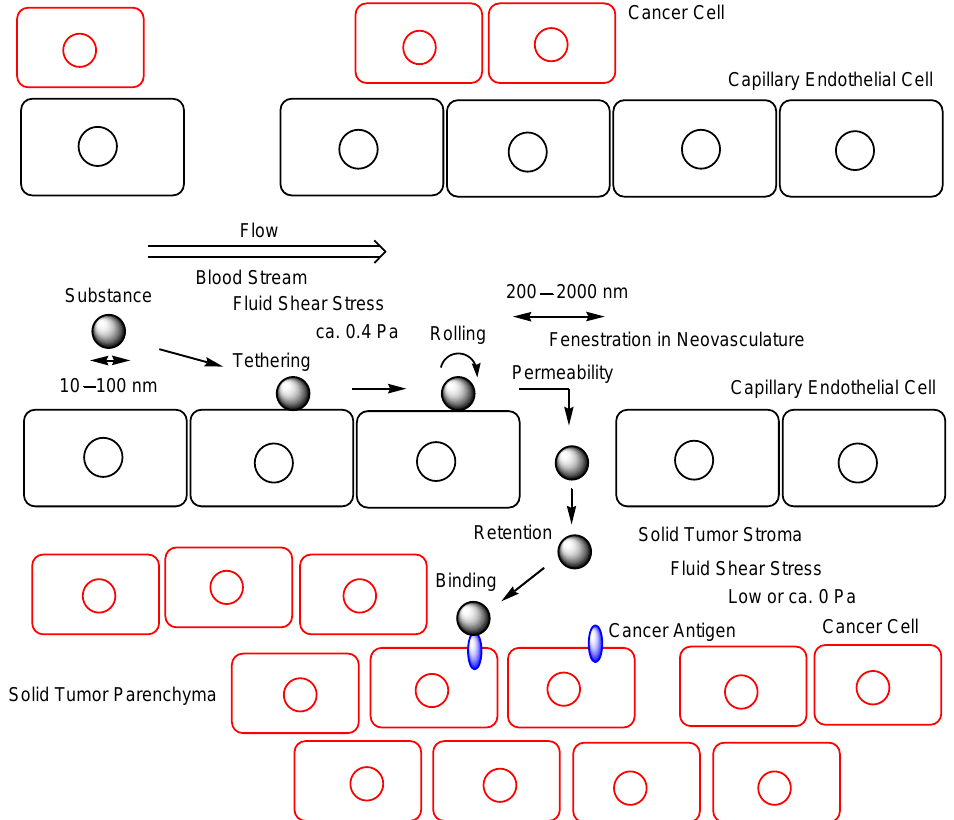
Figure 6. The mechanism of the enhanced permeability and retention (EPR) effect. Substances (10–100 nm in diameter) such as monoclonal antibodies (mAbs) or nanoparticles spontaneously penetrate into solid tumor stroma or parenchyma through the capillary endothelial fenestration, ranging from 200 to 2000 nm, in neovasculature, caused by vascular endothelial growth factor (VEGF) secreted from cancer cells, due to wall fluid shear stress (FSS) (approximately 0.4 Pa), and, subse- quently, remain there because of an underdeveloped lymphatic system in solid tumor parenchyma and high-pressure interstitial fluid in deep cancer